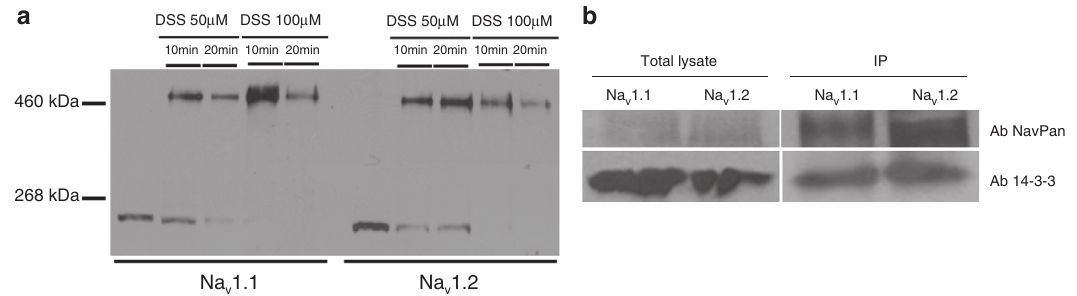
Fig. 8 Na v 1.1 and Na v 1.2 form dimers and co-immunoprecipitate with 14-3-3. a Crosslinking from HEK293 cells transfected with either Na v 1.1 or Na v 1.2. Crosslinker used was DSS at either 50 or 100 μ M for 10 or 20 min. b Co-immunoprecipitation of 14-3-3 with Na v 1.1 and Na v 1.2 in transfected HEK293 cells. Complex was co-immunoprecipitated using the sodium channel NavPan polyclonal antibody. Both sodium channel and 14-3-3 antibodies were used to reveal the interaction. Bands were shown in all conditions indicating interaction between Na v 1.1 or Na v 1.2 with 14-3-3. Full blots are presented